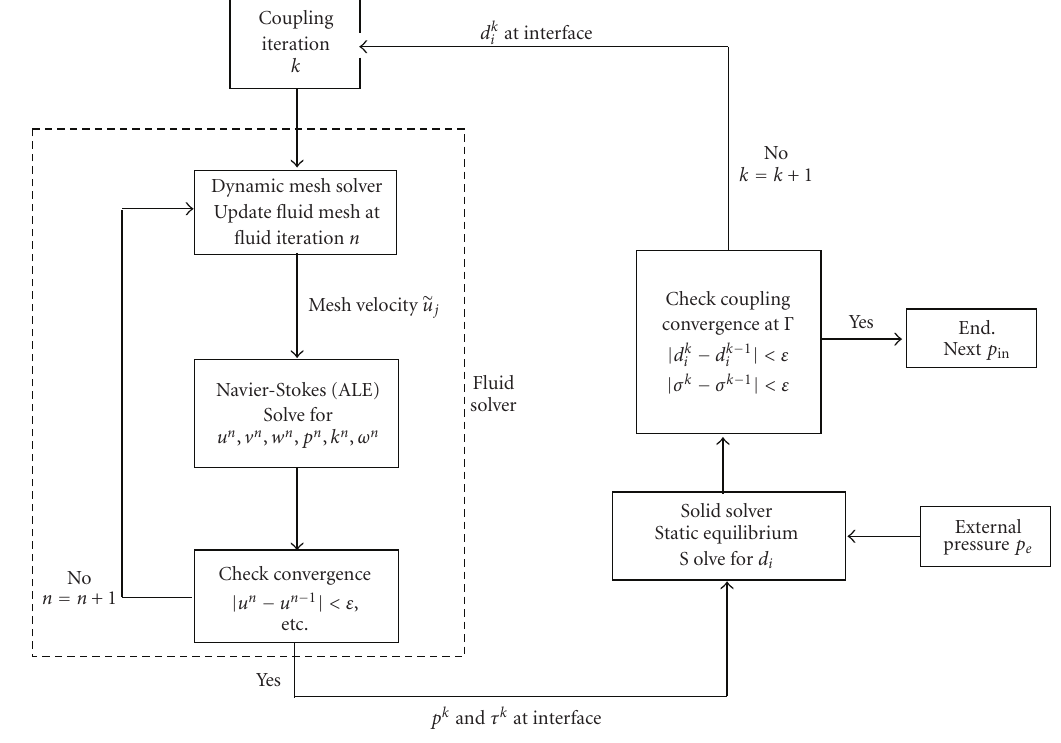
Figure 3: Fluid-structure coupling flowchart.